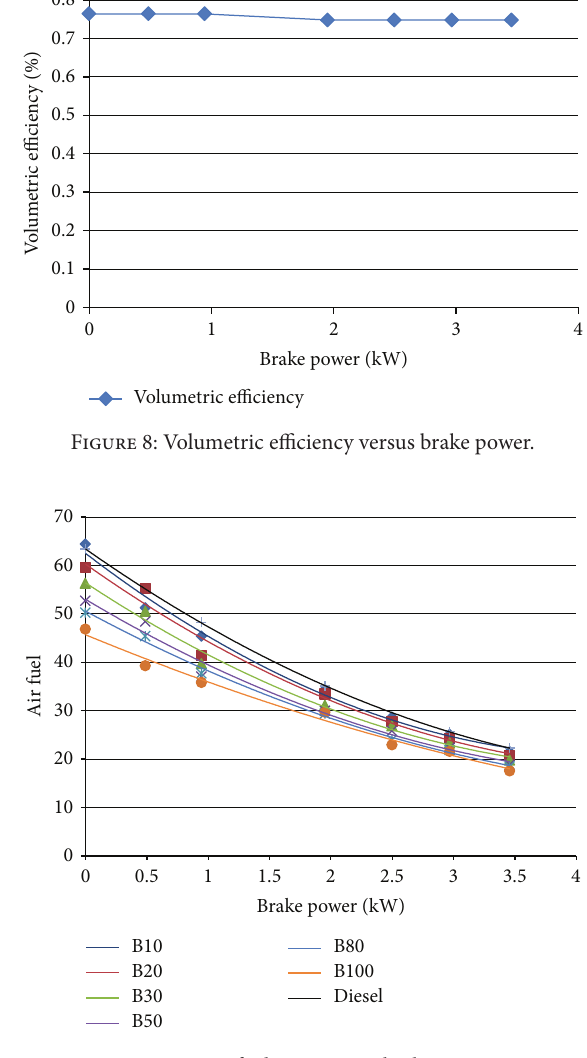
Figure 9: Air fuel ratio versus brake